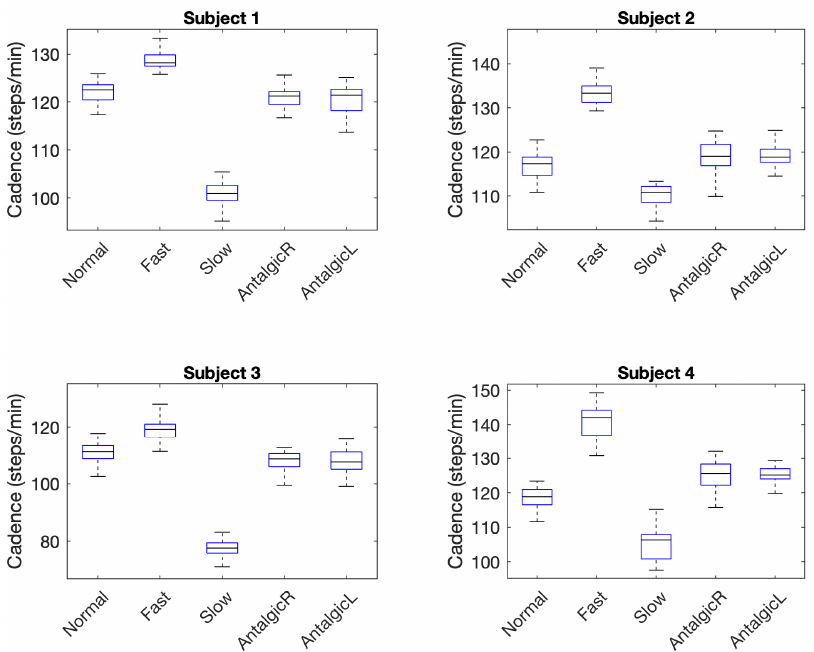
Figure 6. Boxplots of Cadence Indicating Differences in Stride Type.